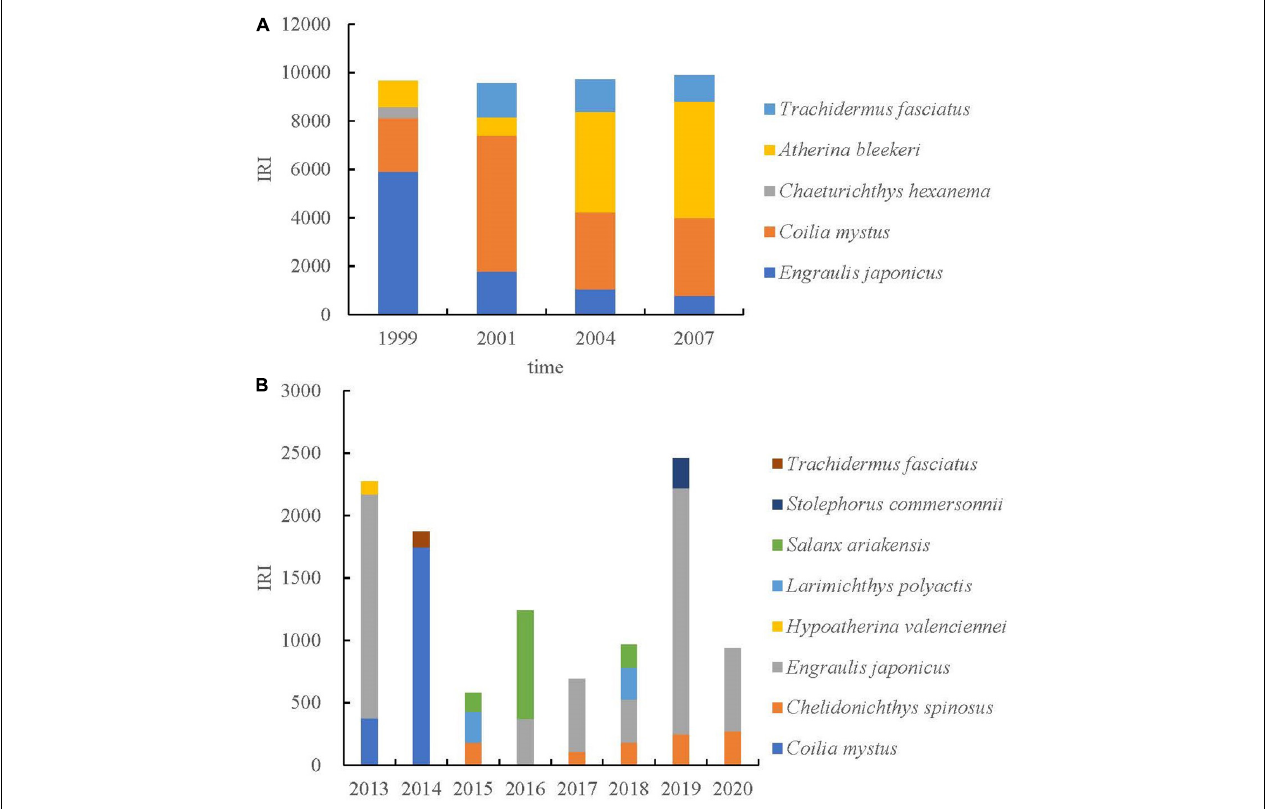
FIGURE 3 | Variations on ichthyoplankton dominance (IRI) and species composition in the Yangtze Estuary in spring. Panel (A) represented published data (Zhang et al., 2015); panel (B) represented the data of this study. Because the original abundance data were not obtained in the literature, the dominance data (IRI) were used for